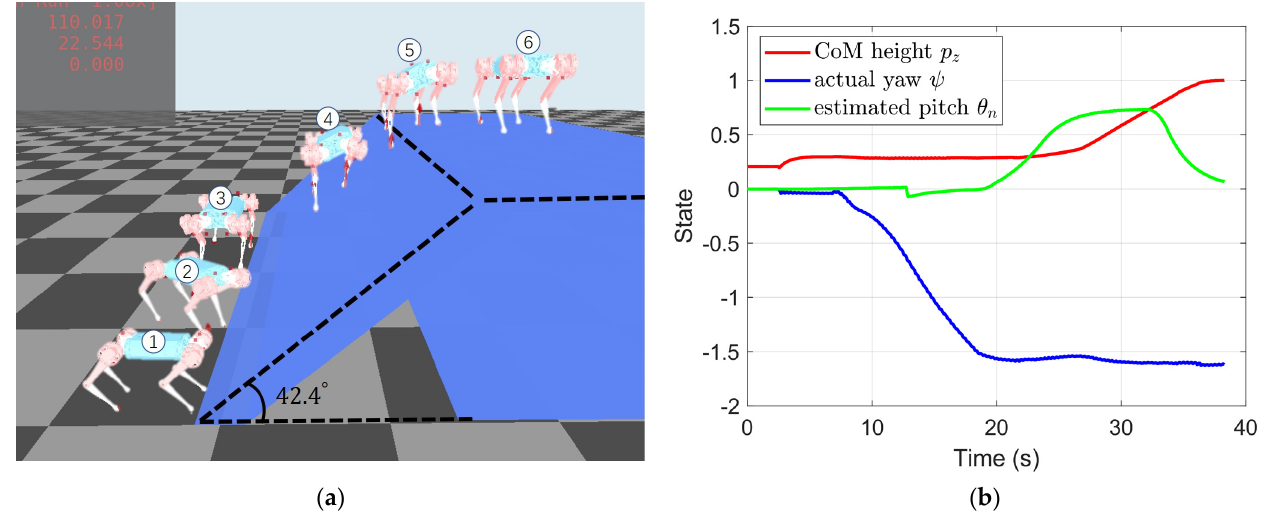
Figure 12. Process of extreme climbing. ( a ) Snapshot of the uphill process; ( b ) State of the uphill process.